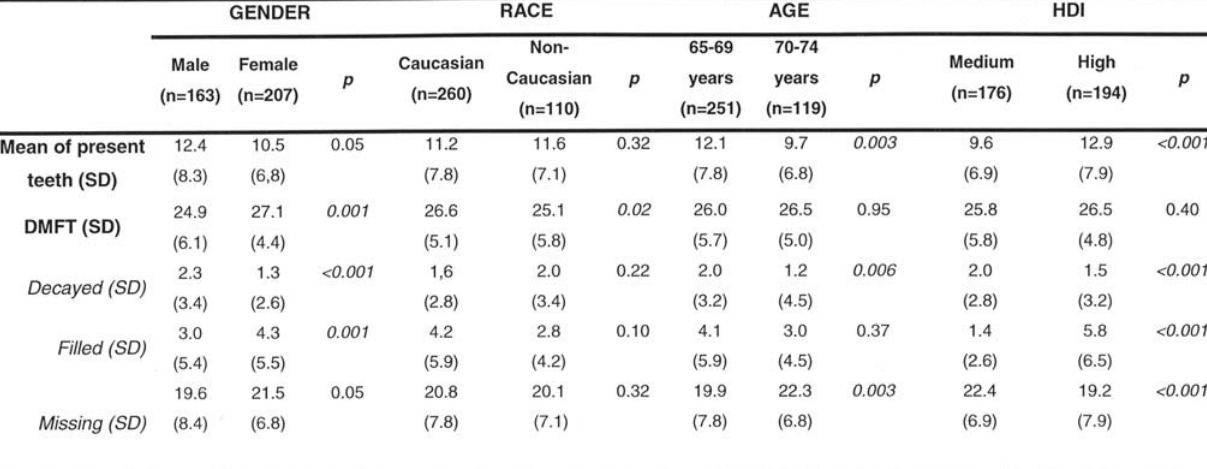
Means followed by different letters in rows indicate statistically significant difference according to city size. TABLE 3- Clinical variables in dentate individuals according to gender, race, and age. Southern Region of the state of São